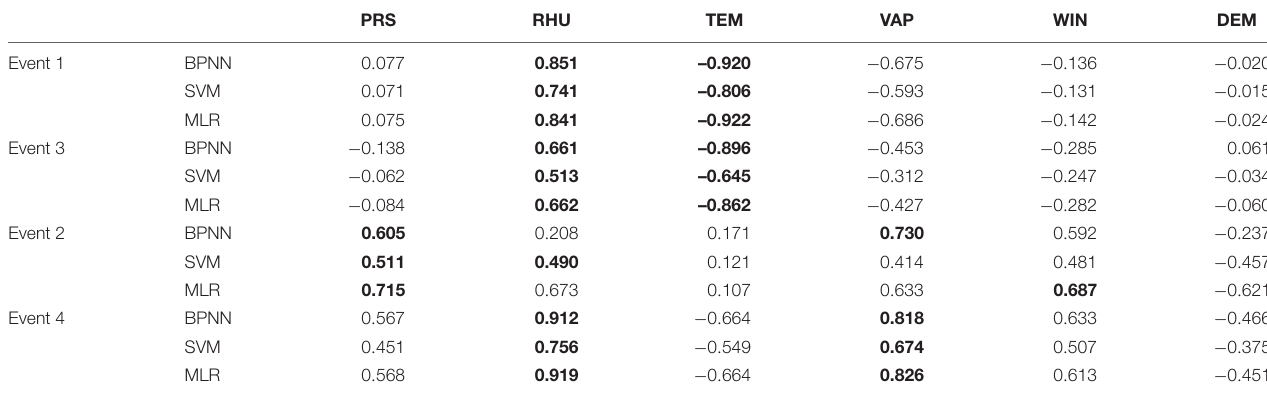
TABLE 1 | The Pearson correlation coefficients (CC) between the six factors and the two downscaled datasets in four precipitation events (the two largest absolute CC values were in bold for each